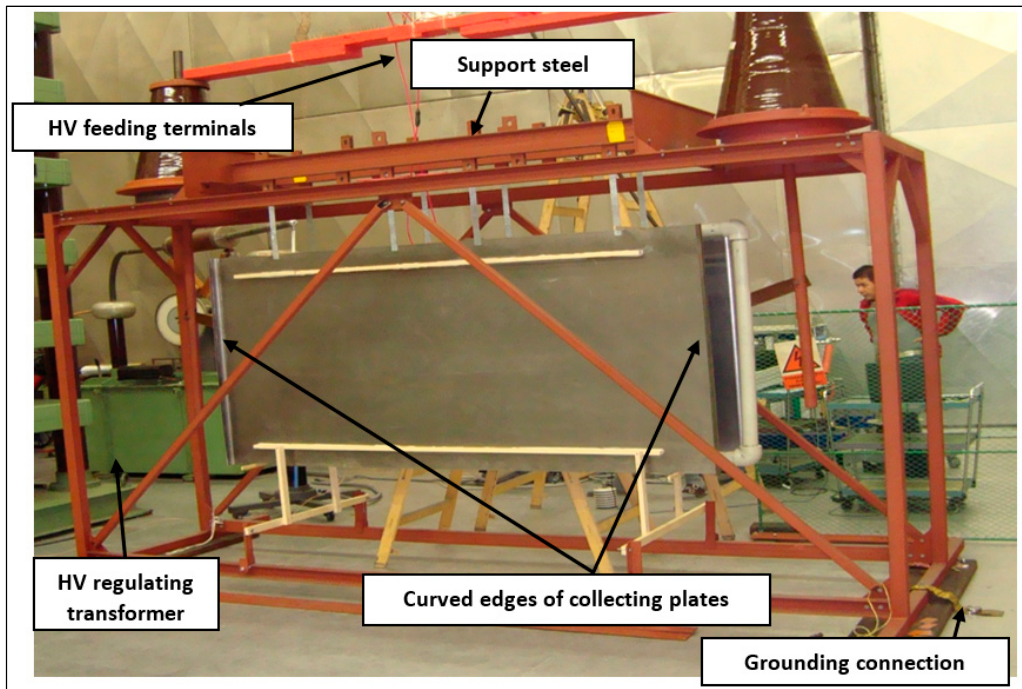
Figure 10. An experimental model configuration of WDESP; Laboratory of High Voltage Engineering